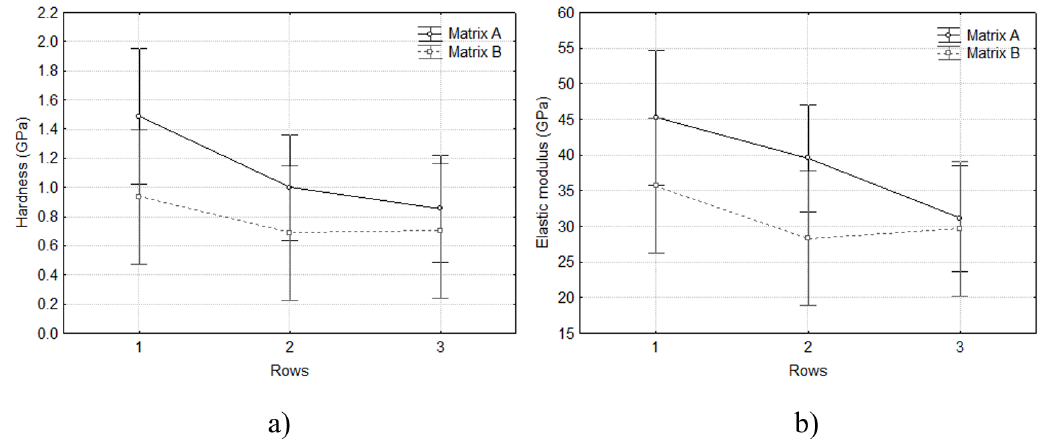
Figure 6. Mean results of hardness (a) and elastic modulus (b) obtained by the nanoindentation technique for two different 24 indentation points matrices located at the microfiber-paste interface, where row 1 is the farthest and row 3 is the closest to the